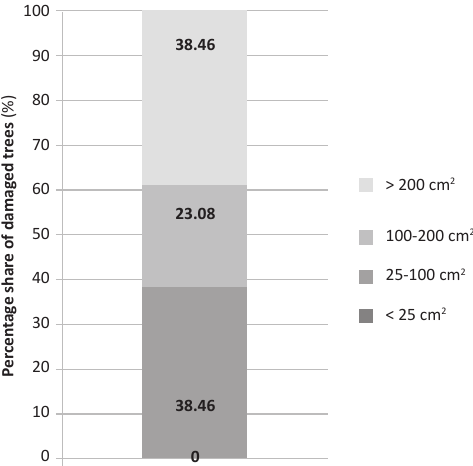
FIgURe 6. The distribution of damages depending on dama- ge